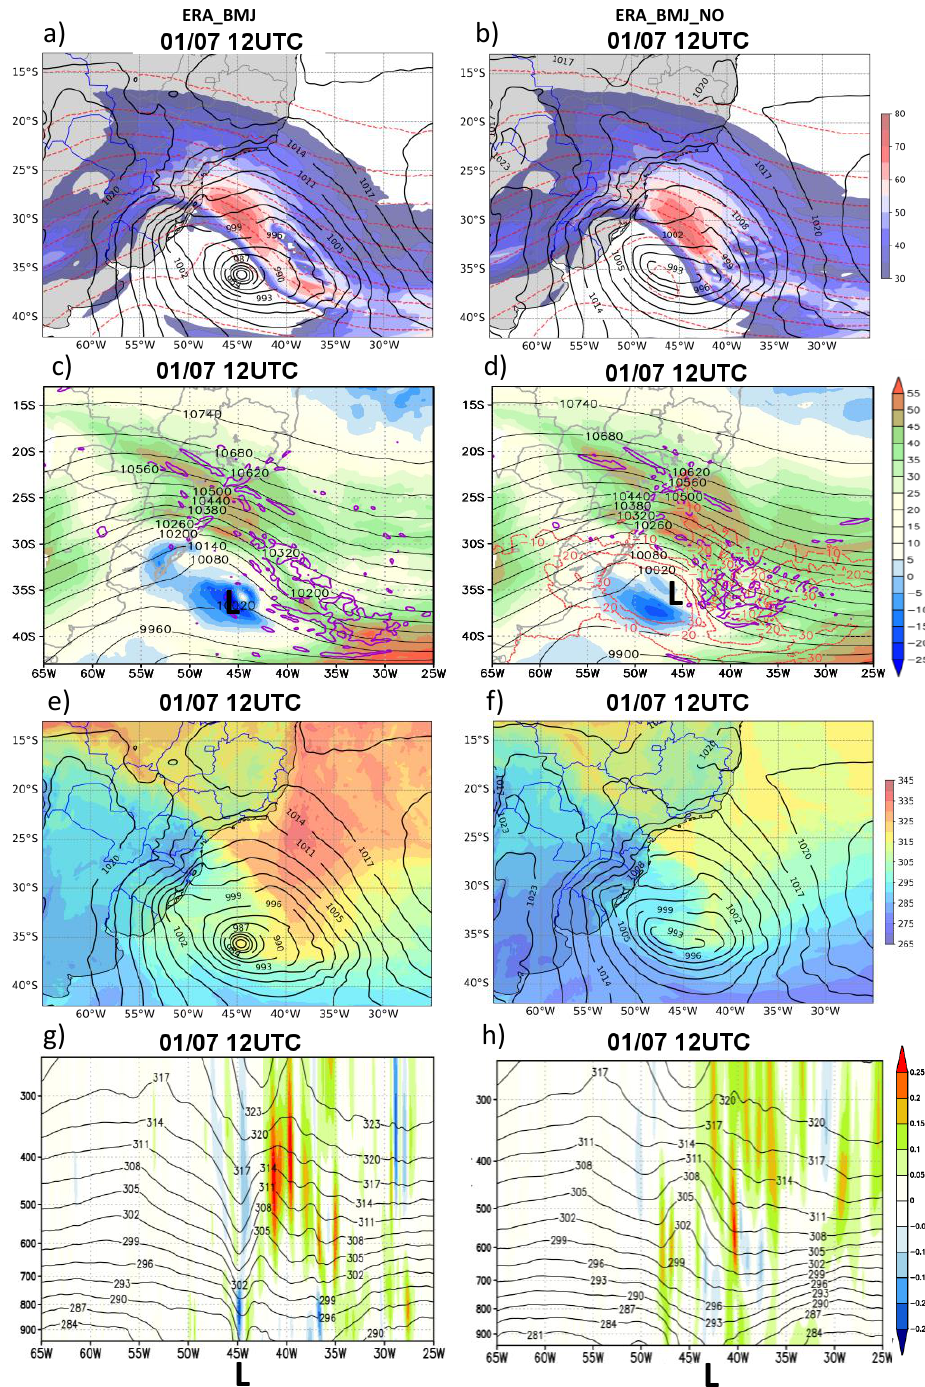
Figure 8. Synoptic environment in ERA_BMJ (left column) and in ERA_BMJ_NO (right column) at 1200 UTC on 1 July 2020 (time at which the cyclone reaches explosive status in ERA5 and in the ERA_BMJ simulation). ( a , b ) PNMM in black lines with intervals of 3 hPa, 500 – 1000 hPa thickness (mgp, dashed red lines), and wind intensity at 250 hPa greater than 30 m s −1 (shaded); ( c , d ) vertical wind shear between 850 – 250 hPa (m s −1 ; shaded), geopotential height (mgp; black lines) at 250 hPa, and mass divergence at 250 hPa greater than 1 × 10 −5 s −1 (purple lines); in ( d ), in the dashed red line, the geopotential height difference between ERA_BMJ_NO and ERA_BMJ is also shown; ( e , f ) equivalent potential temperature at 850 hPa (K, shaded) and MSLP (hPa, black lines); and ( g , h ) vertical cross section at 36° S, of 𝜃 e (K; black lines), and vertical velocity W (m s −1 , shaded, where positive values indicate upward movement). The letter L indicates the cyclone center based on the MSLP.